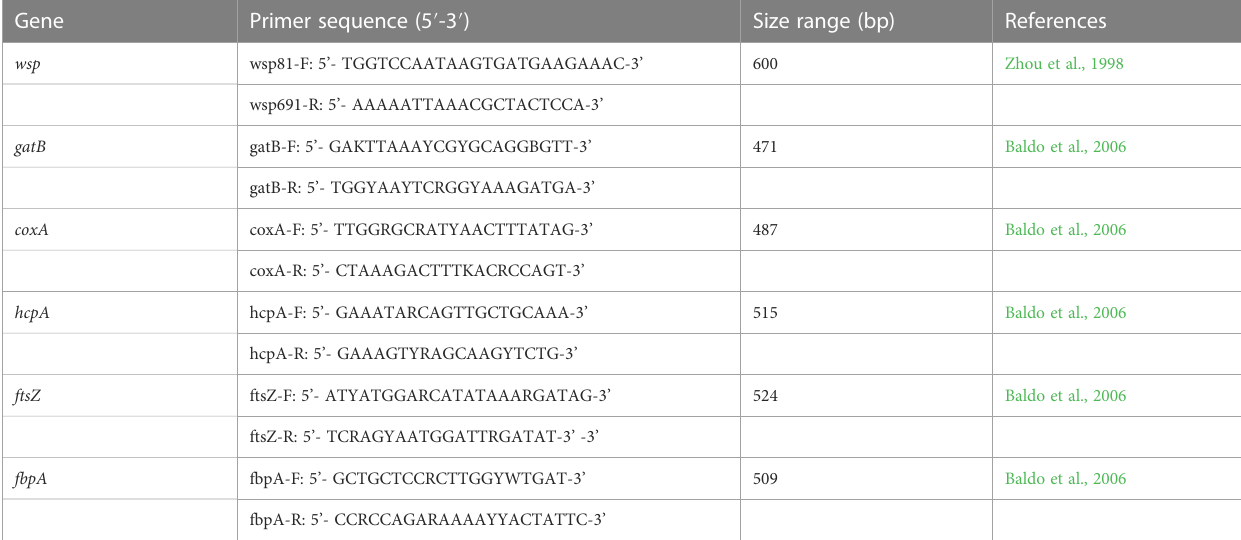
TABLE 1 The primers used for wsp and MLST gene ampli fi cation of Asian citrus psyllid and longan psyllid. Gene Primer sequence (5 ′ -3 ′